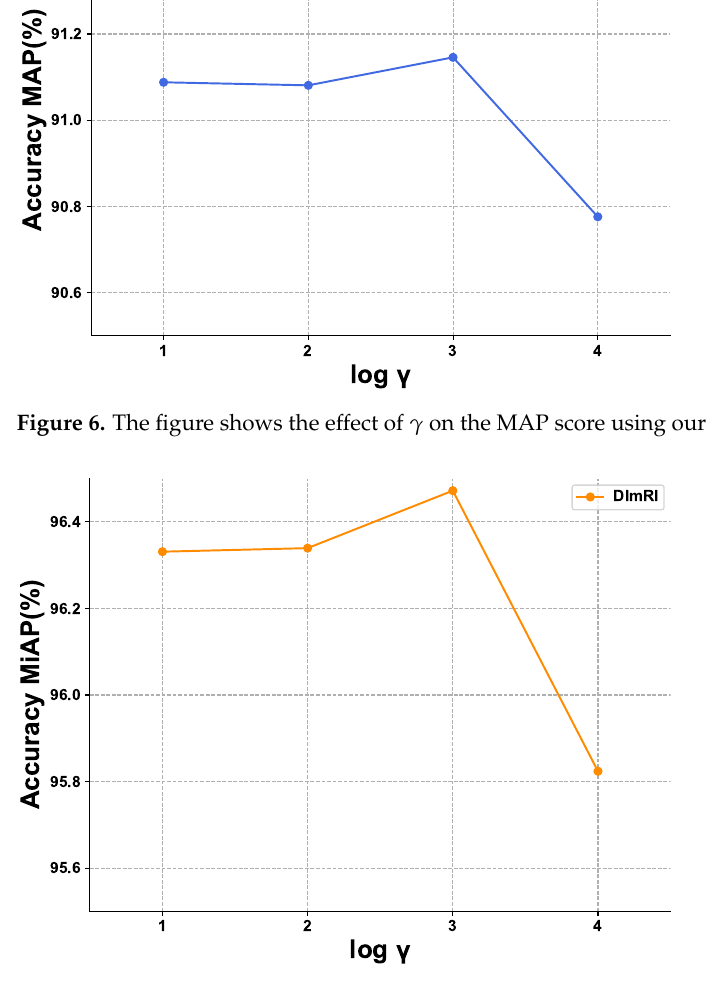
Figure 7. The figure shows the effect of γ on the MiAP score using our